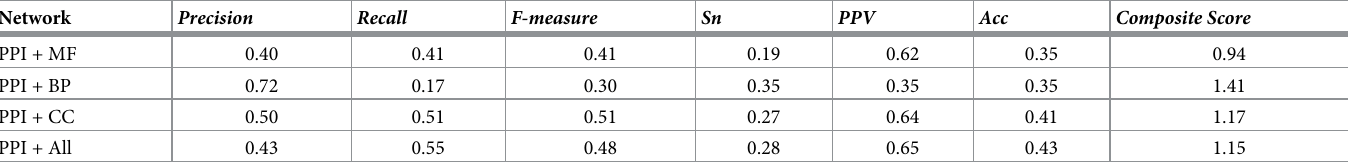
Table 5. Performance of LCDA - GO on Saccharomyces Cerevisiae from Krogan interaction datasets. Network Precision Recall F - measure Sn PPV PPI +